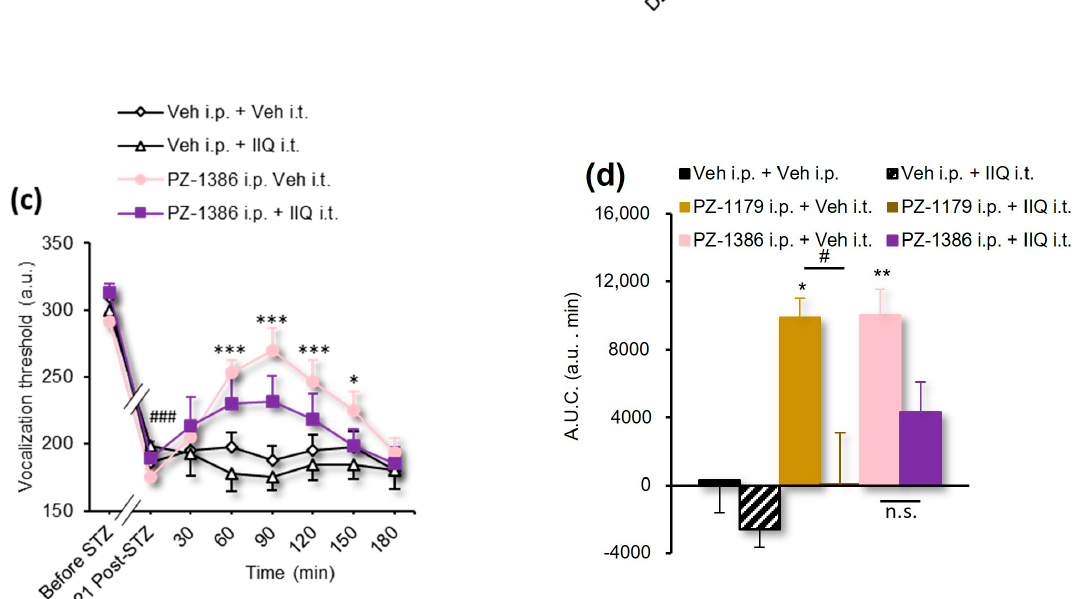
Commented [M2]: Figure 2(d) revised.